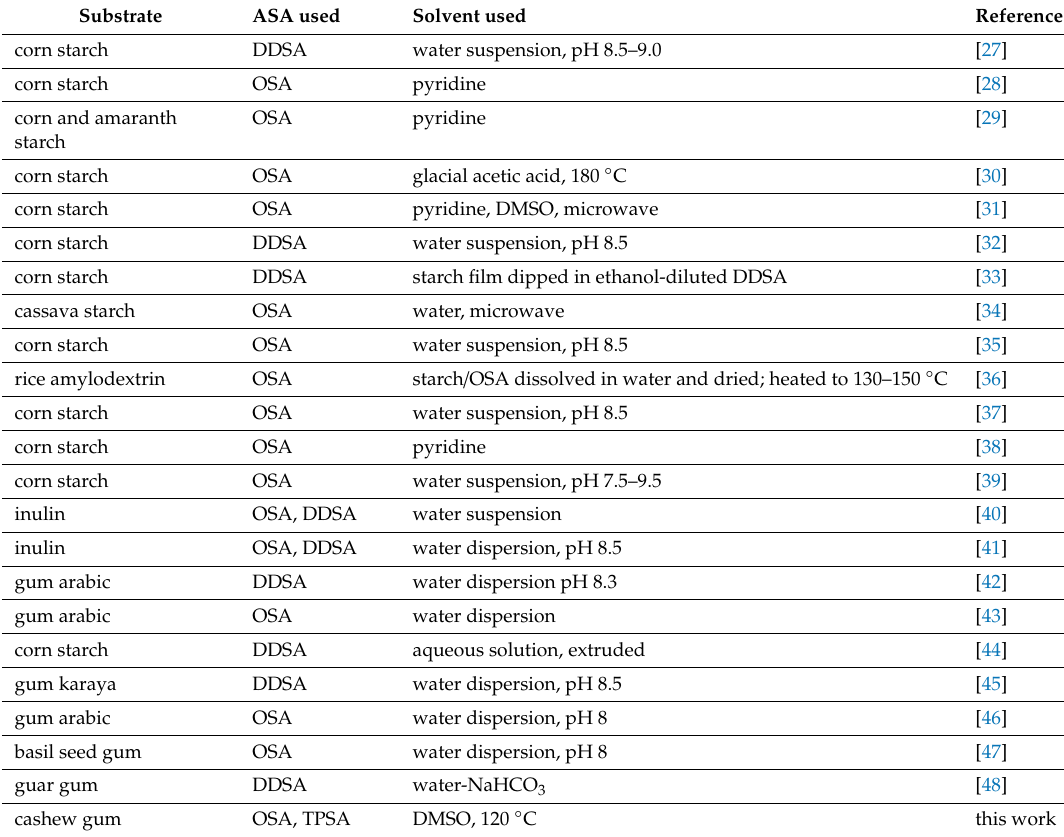
Table 1. Selected polysaccharides’ ASA derivatives. ASAs used included n -octenyl succinic anhydride (OSA), n -dodecyl succinic anhydride (DDSA), and tetrapropenyl succinic anhydride